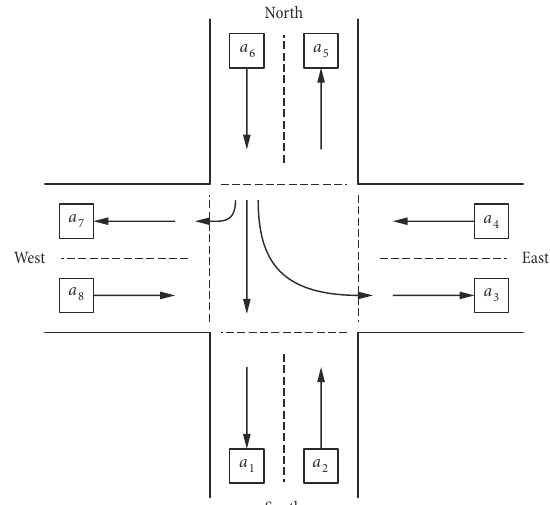
Fig. 2. Intersection